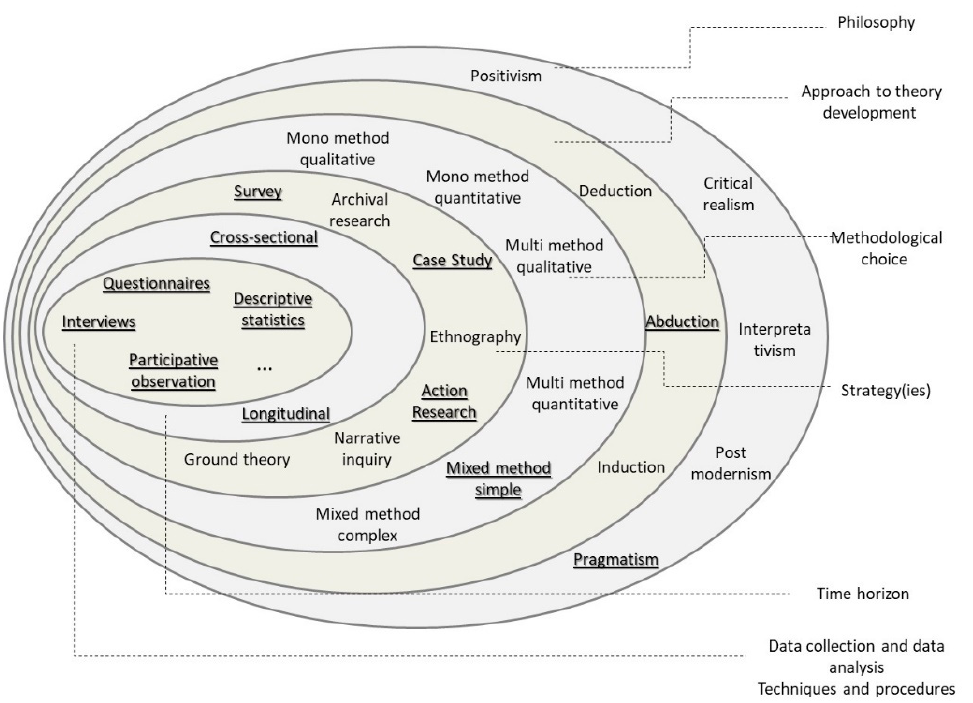
Figure 1. The “research onion” as a reference framework for the design of this research. Source: Adapted from ©2018 Mark Saunders, Philip Lewis and Adrian Thornhill [44].